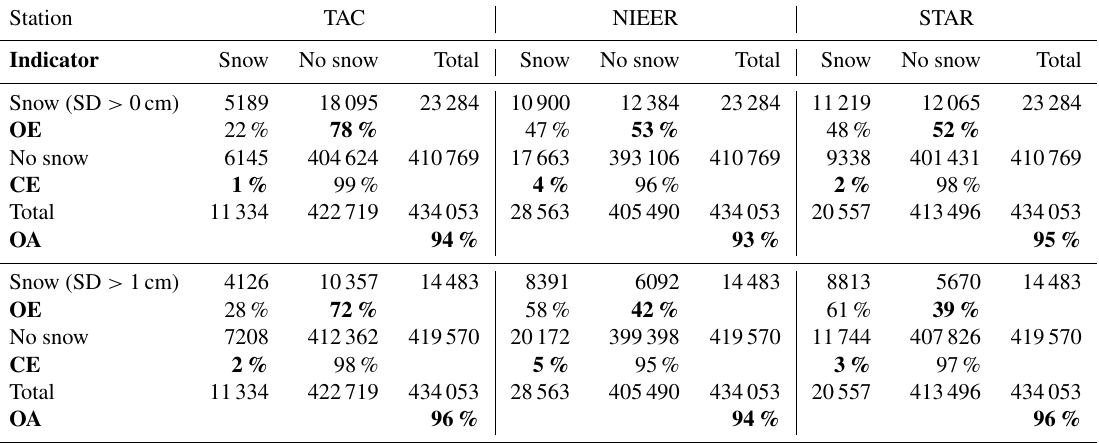
Table 6. Confusion matrices between TAC NDSI, NIEER AVHRR SCE, STAR NDSI datasets and in situ snow-depth (SD) data in QTP from 1 August 2000 to 31 December 2013. Note that bold values indicate classification accuracy, including OE, CE, and